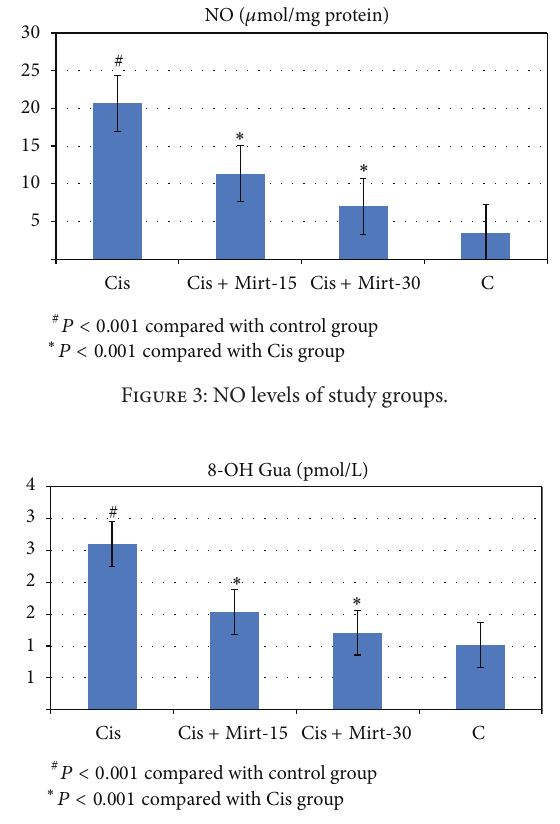
Figure 4: 8-OH Gua levels of study